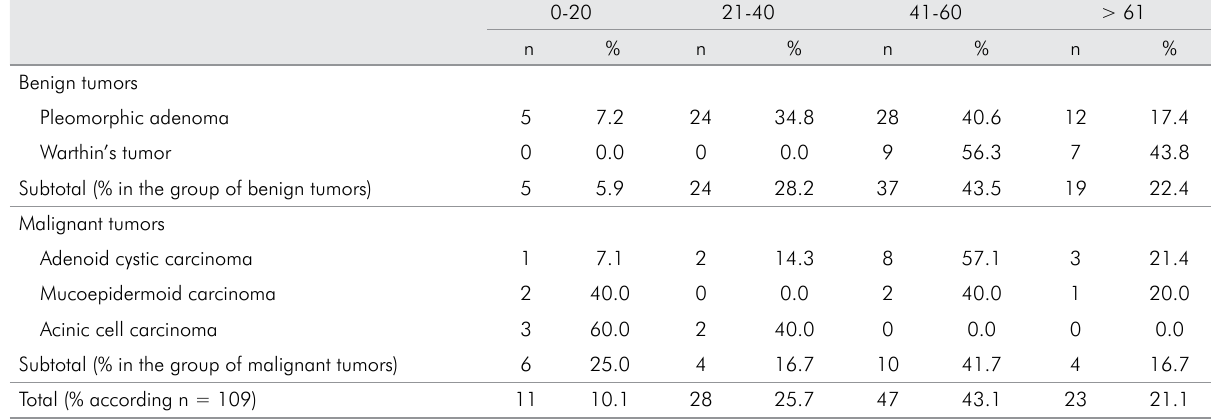
Table 3. Distribution of 109 benign and malignant salivary gland tumors according to age (in